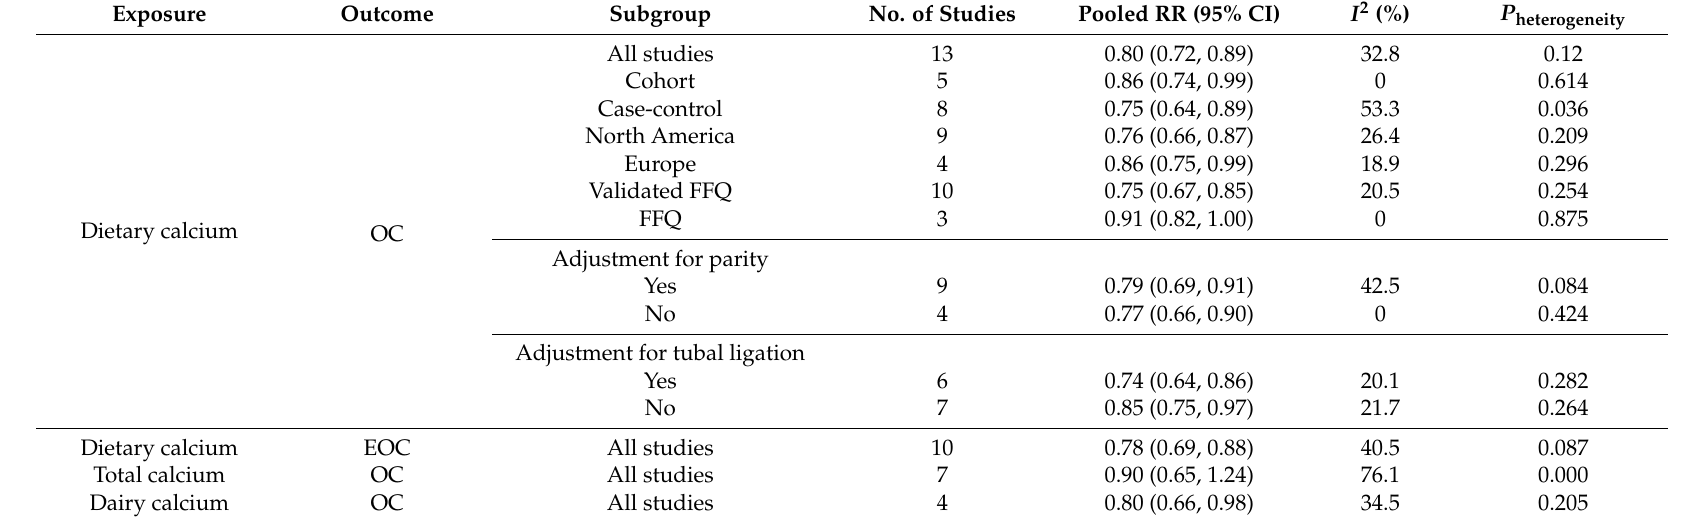
Table 2. Summary risk estimates of the association between the intake of calcium and the risk of ovarian